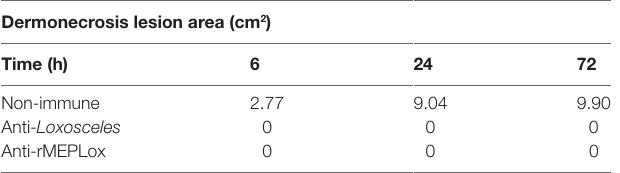
TaBle 2 | Lethality neutralization of L. intermedia venom by anti-rMEPLox serum. survival (%)